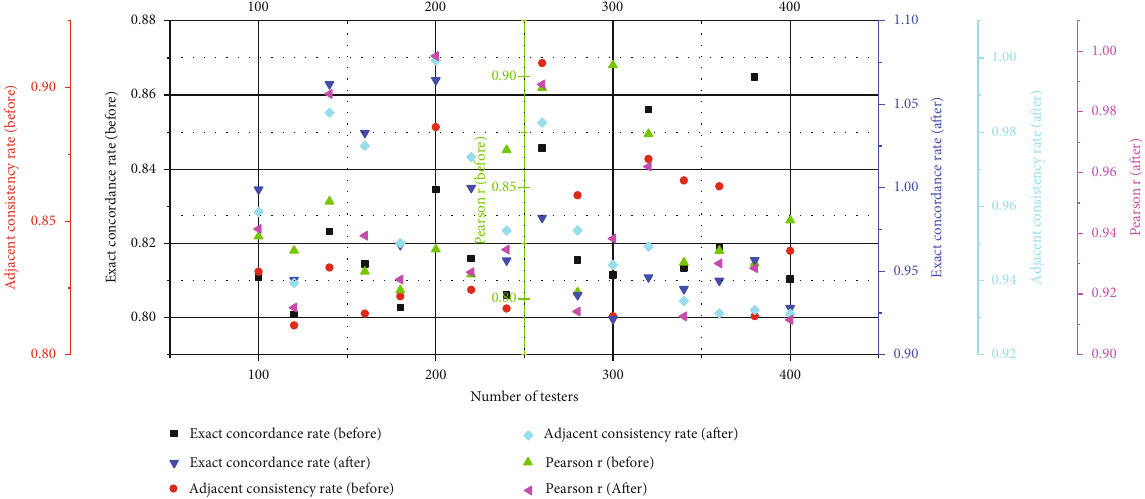
Figure 3: Comparison of the reliability of human-machine evaluation between the two groups.